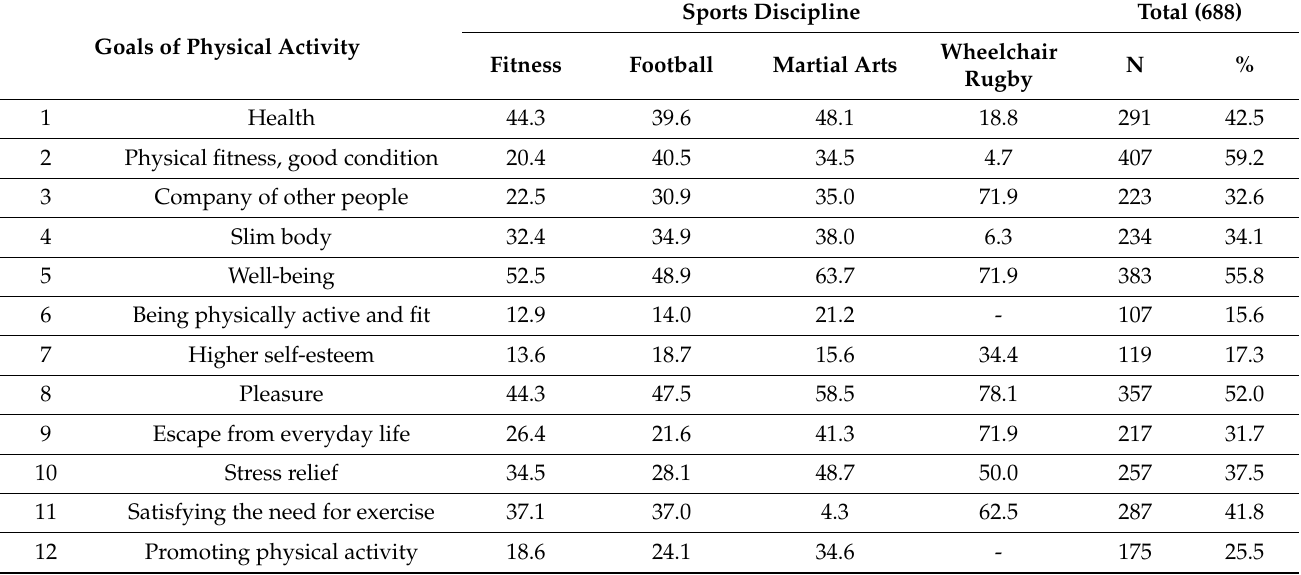
Table 2. The most important goals for physical activity (IPAO)